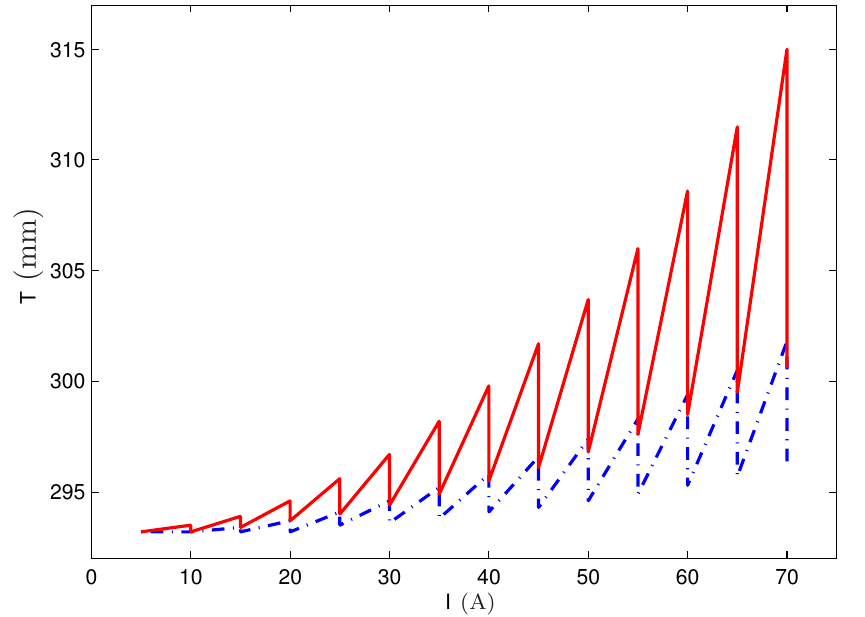
Figure 12. Maximal temperature of the ferrofluid EMG 909 for a consecutive increase of the current from I = 5 A to I = 70 A by ∆ I = 5 A. The waiting time between each increasing step counts to 300 s. The red solid line indicates the development of the temperature for a holding time of ∆ t hold = 5 s at each strength of the current, and the blue dot-dashed one for ∆ t hold = 2